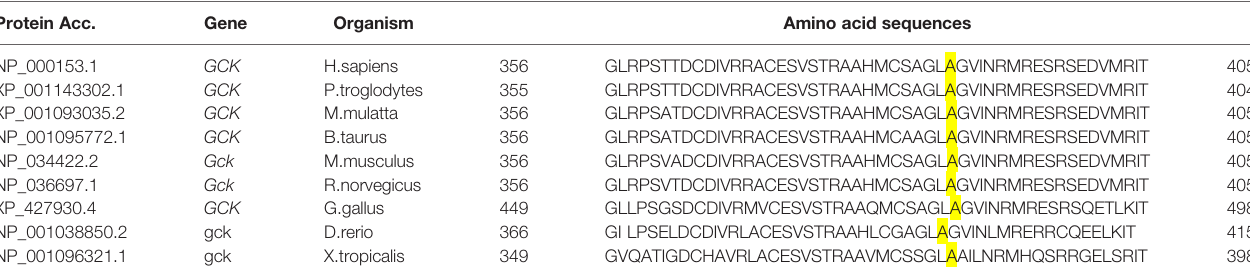
TABLE 7 | Evolutionary conservation analysis of the p.Ala387Val mutation in the GCK gene. Protein